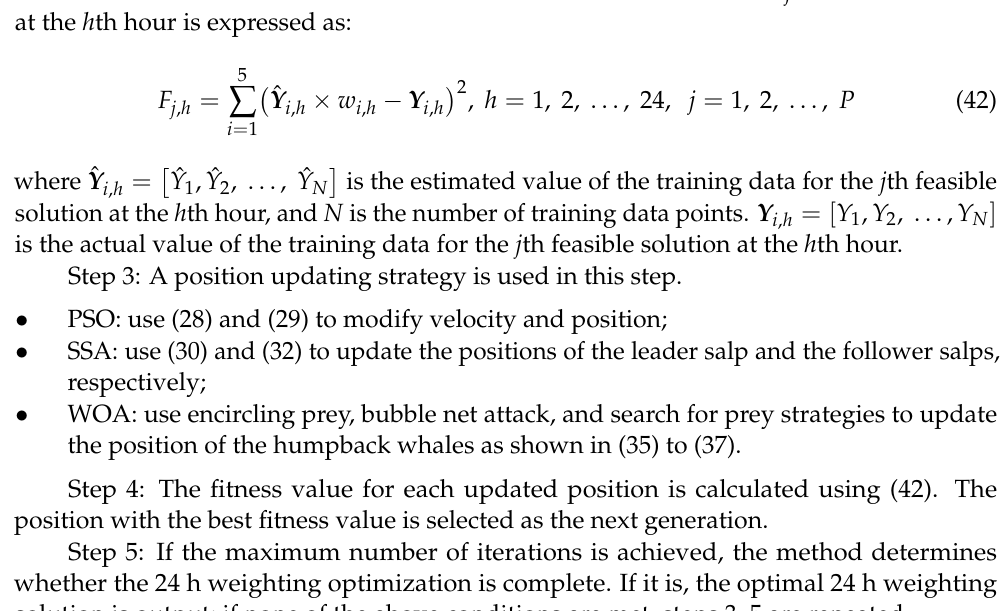
( b ) Figure 8. Curves for wind power data: ( a ) before pre-processing and ( b ) after pre-processing. Figure 9. The elbow curve for collected wind power data. Figure 10. Wind power data classification using a k-means method. Table 2. Prediction error of data before and after classification. Data Type